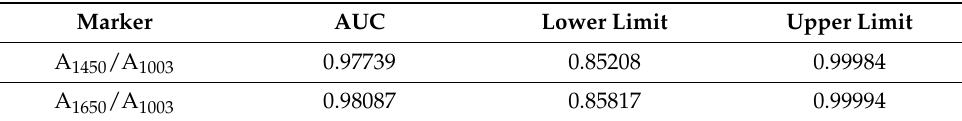
Table 3. AUC results, lower and upper limits at 95% confidence interval, related to A 1450 /A 1003 and A 1650 /A 1003 ratios.